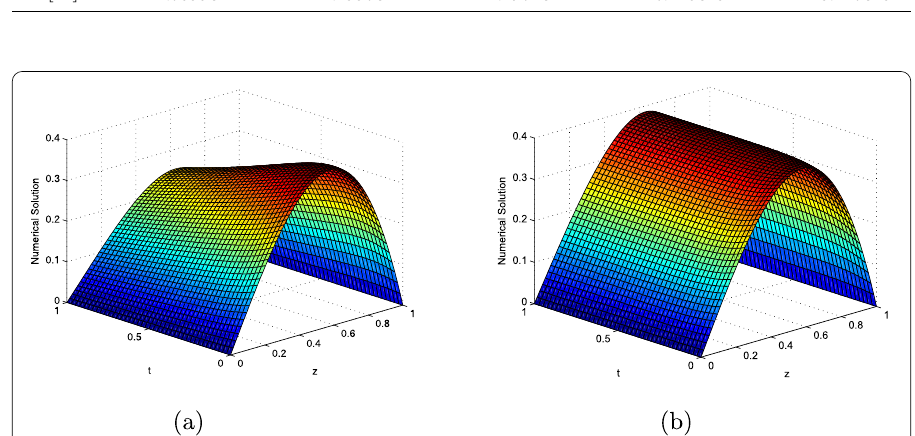
Figure 1 3D view of numerical solution for N = 64, M = 40, ε = 2 –18 : ( a ) Example 5.1, ( b ) Example 5.2